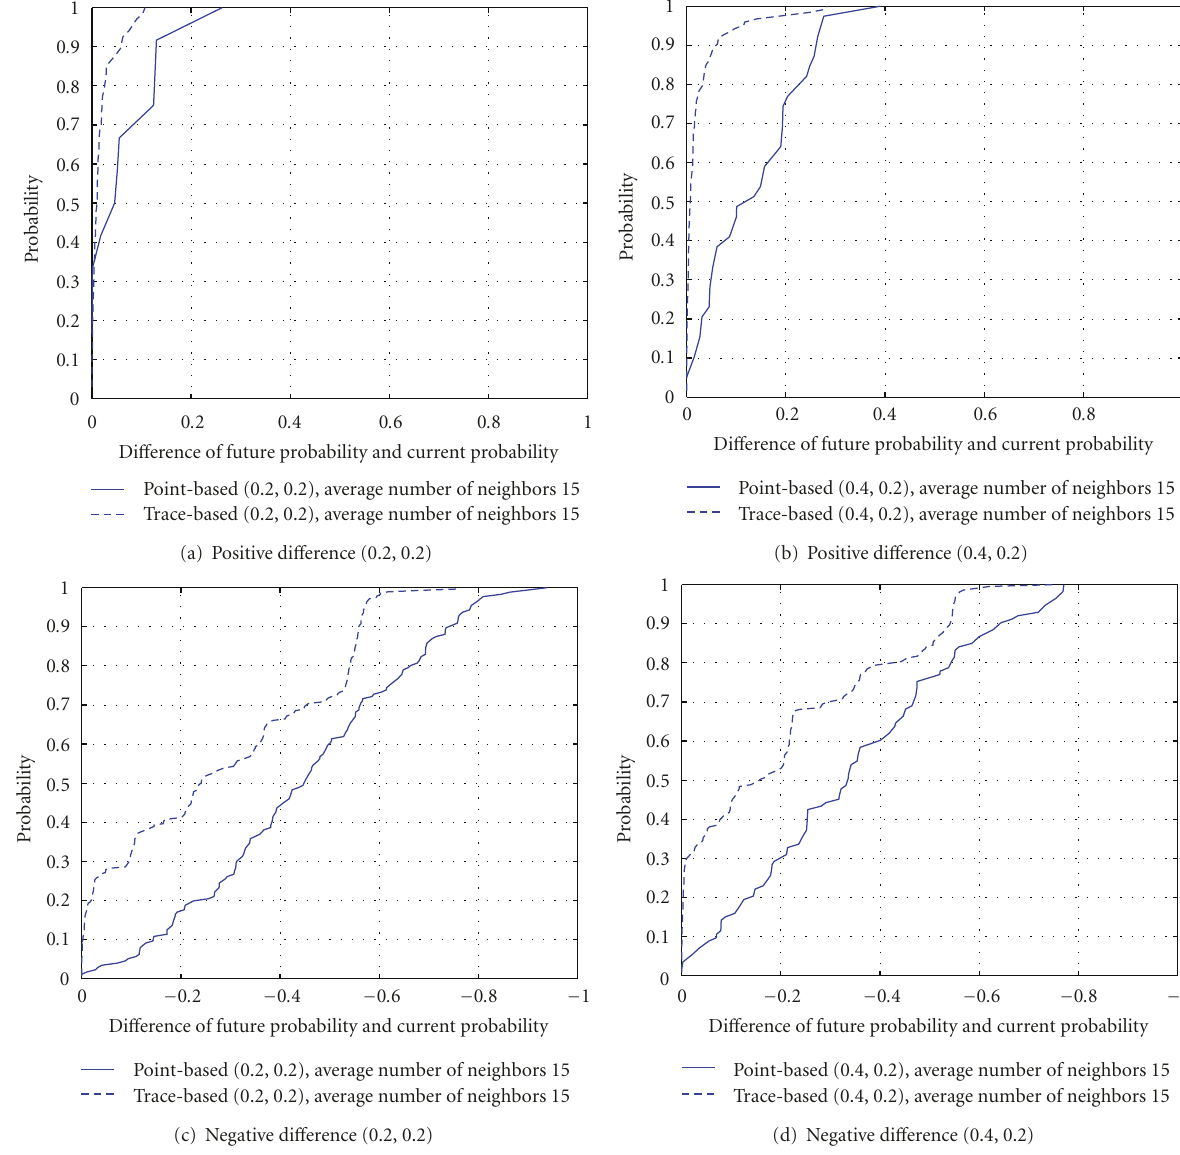
Figure 8: Cumulative Distribution Function (CDF) of the di ff erence of the future probability Pr dt to the past probability Pr dt of the near likely node under the case of the average number of neighbors is 15 in walking scenario.